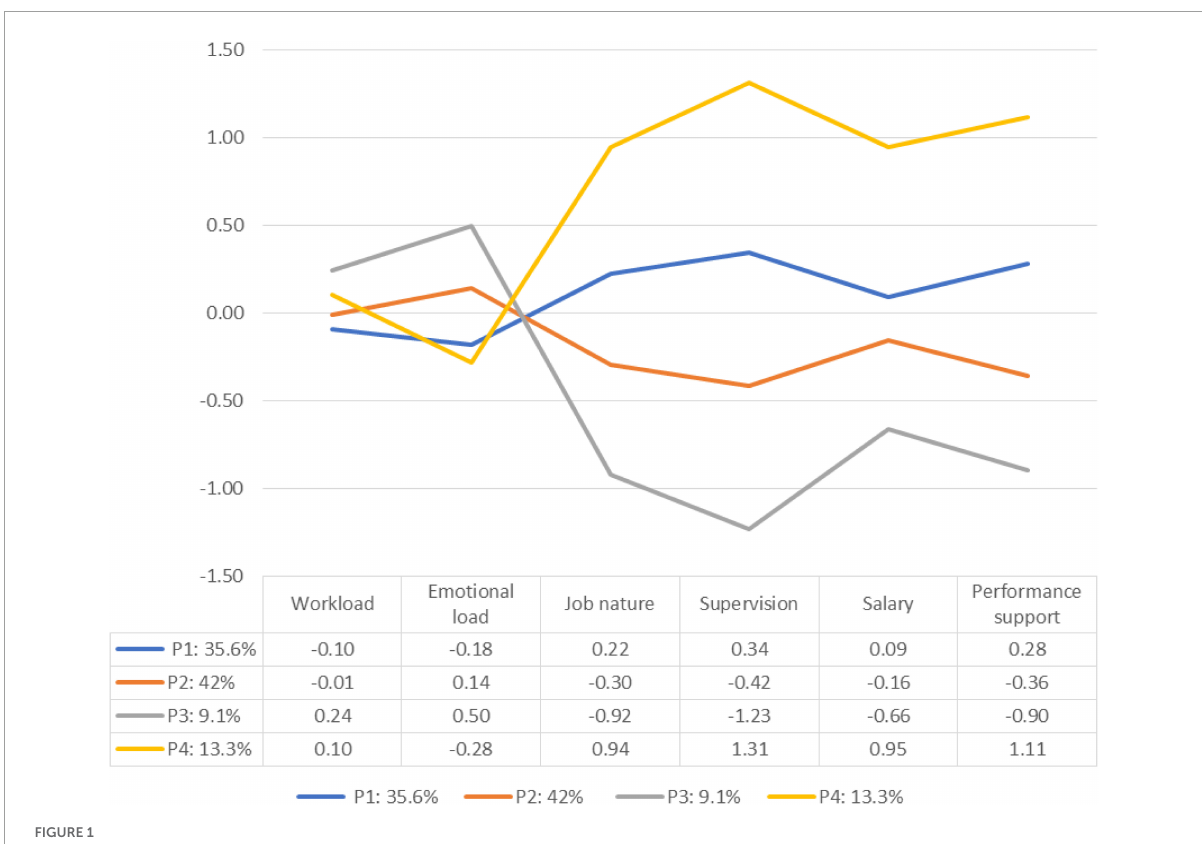
FIGURE1 Latent profiles of job demands and resources of special education teachers.